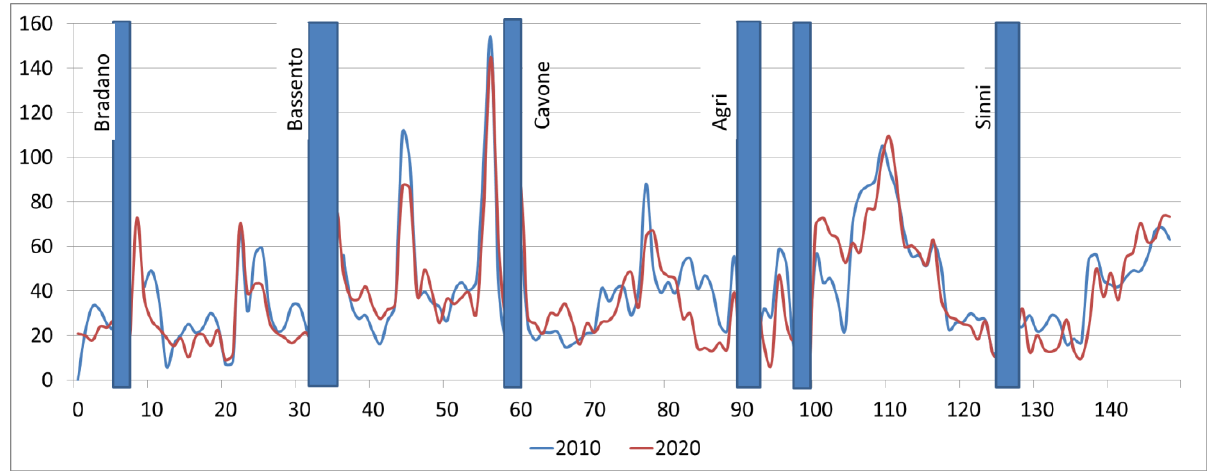
Figure 5. Beach width (in m) in 2010 and 2020. The numbers indicate the transects from north to south. The blue lines represent the limits of the macro-area.